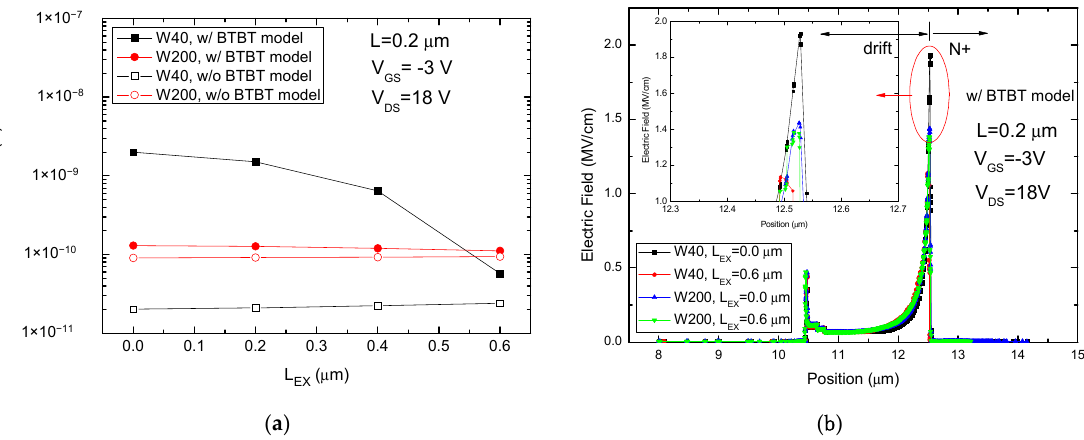
Figure 7. ( a ) Variation in the GIDL current with a wide drain length for W40 and W200 at V GS = − 3 V and V DS = 18 V. ( b ) Electric field distribution of W40 and W200 with L EX = 0 and 0.6 μ m at V GS = − 3 V and V DS = 18 V.